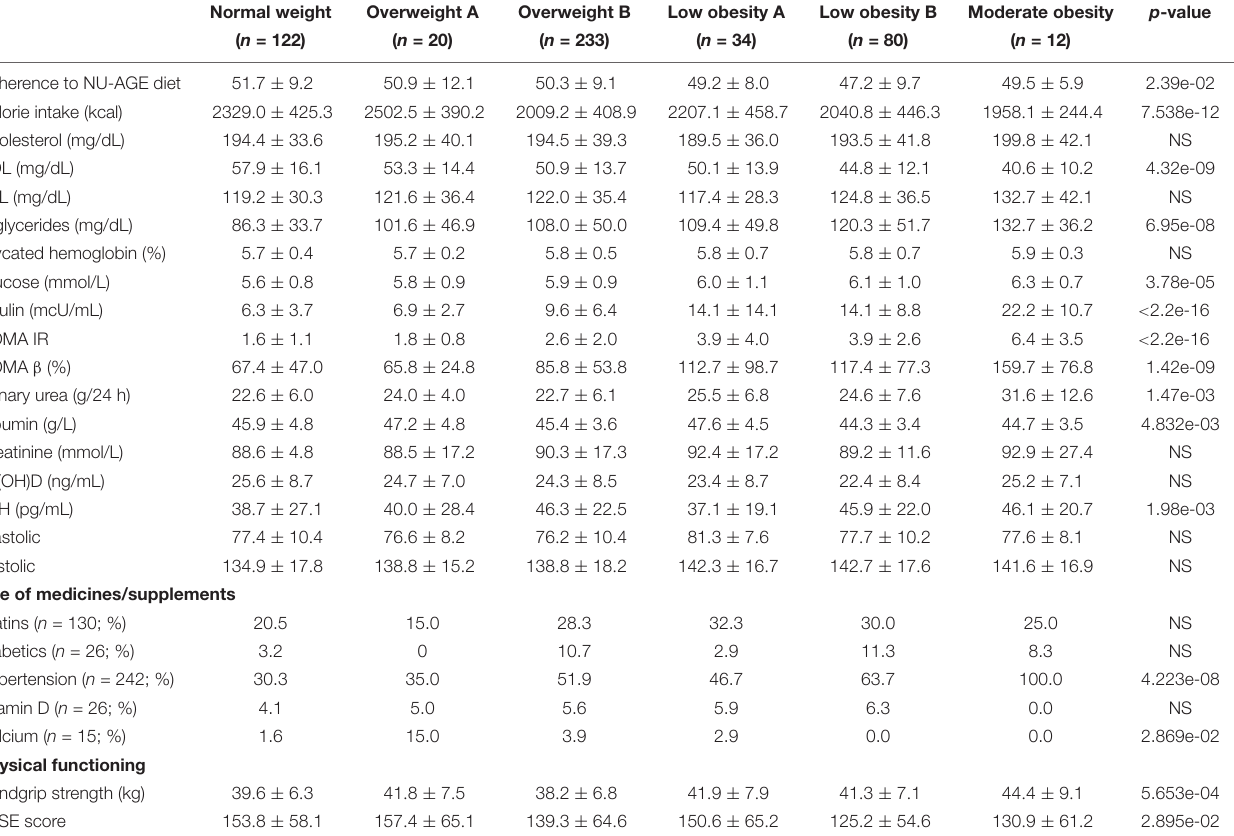
TABLE 4B | Metabolic profile across the six body composition clusters in men. Normal weight Overweight A Overweight B Low obesity A Low obesity